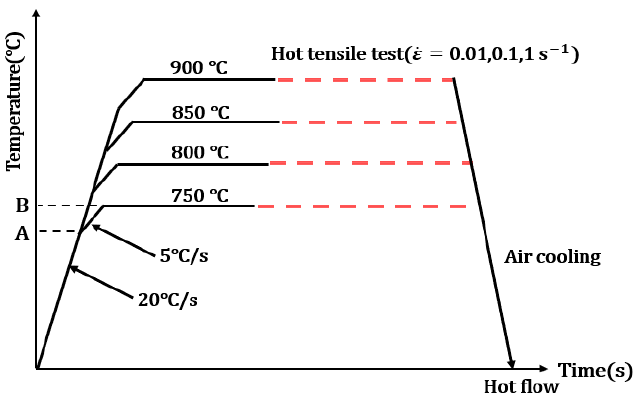
Figure 3. Temperature profile of the uniaxial tensile tests.